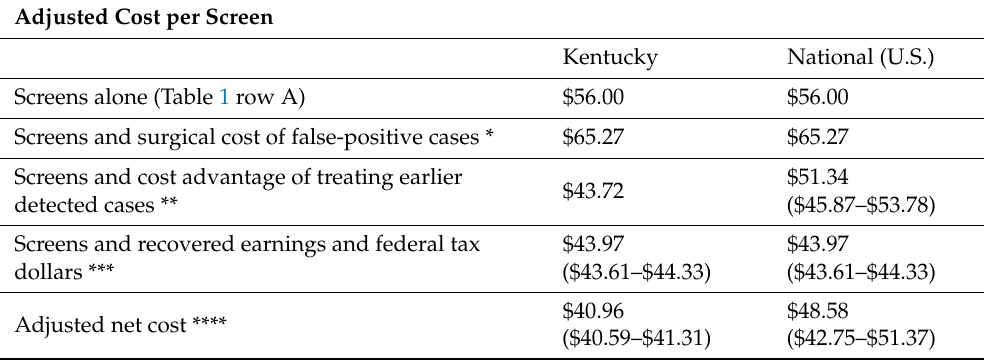
* (Table 6A + 6B) / 326,998; ** (Table 6 row A − Table 6 row C) / 326,998; *** (Table 6 row A − Table 6 row D + Table 6 row E) / 326,998; **** (Table 6 row F) /